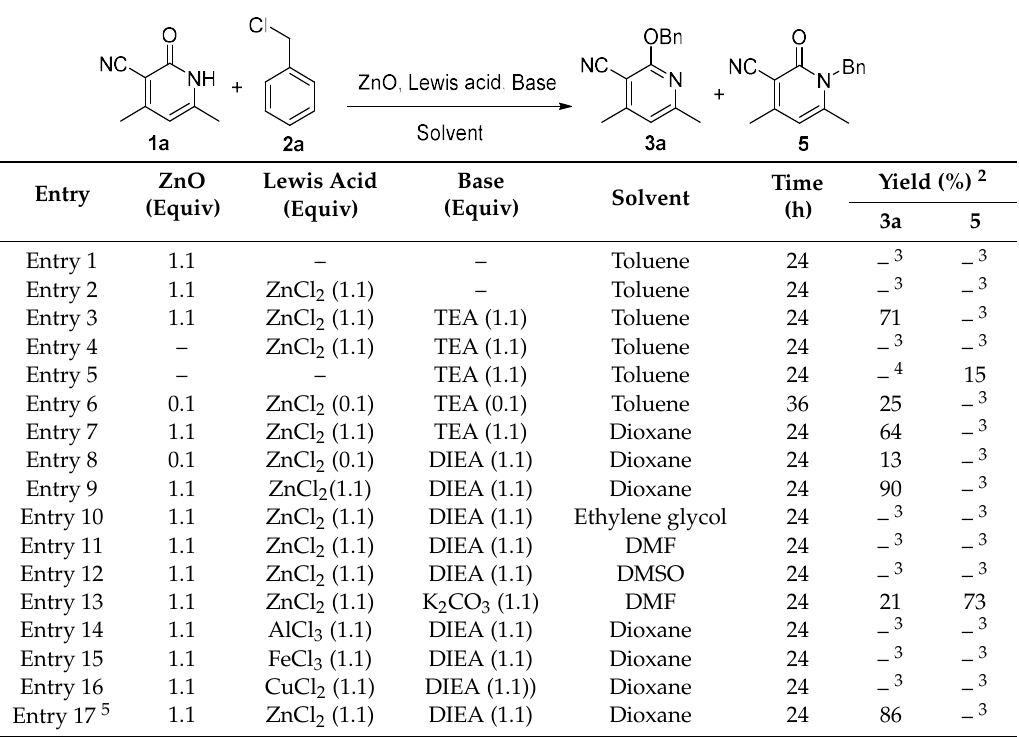
Table 1. Optimization of the reaction conditions for the O -benzylation of 1a and 2a 1